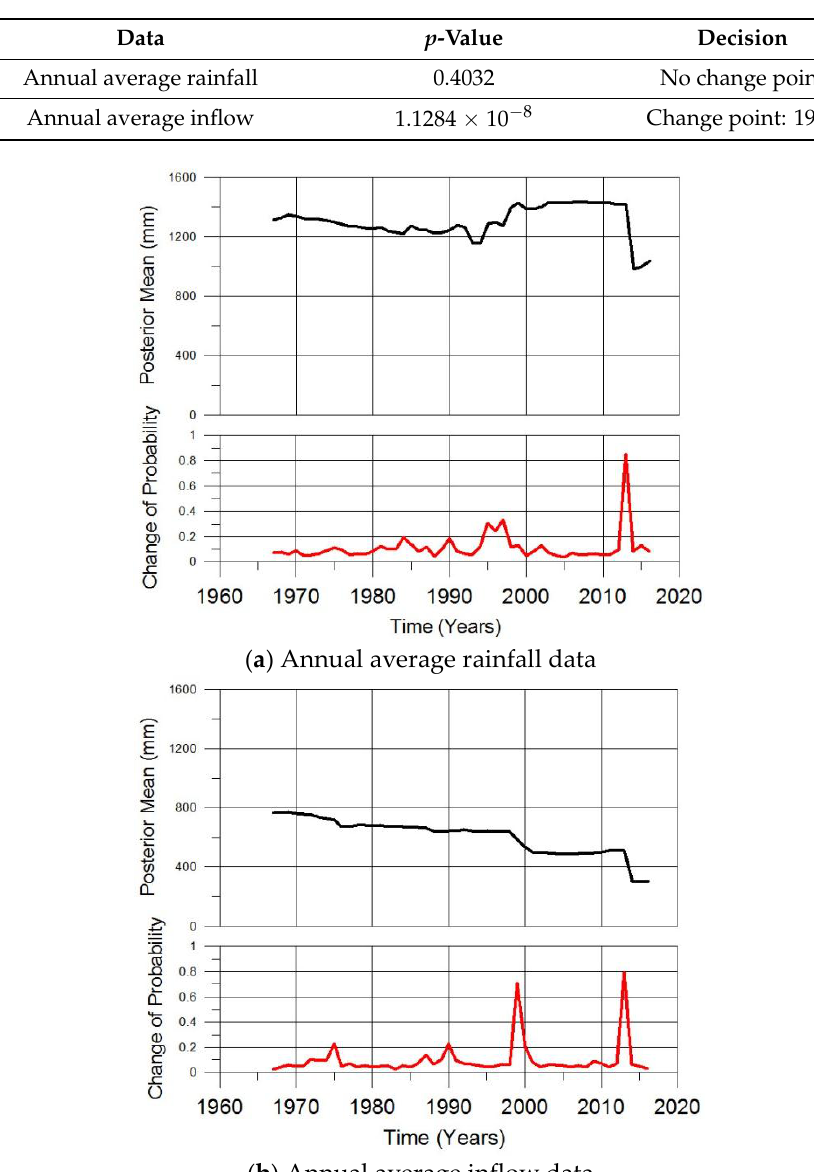
Table 4. Results of Pettitt’s test (significance level: 5%).